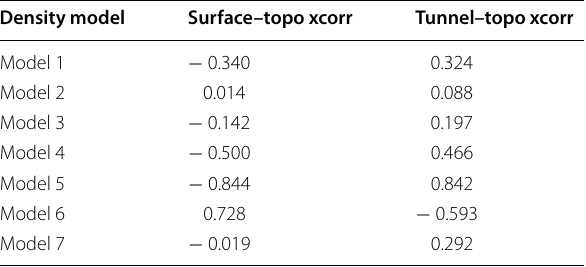
To compute the cross-correlation, the topography along the model line has been sampled as the same x-coordinate as the gravity data, as shown in Fig. 8